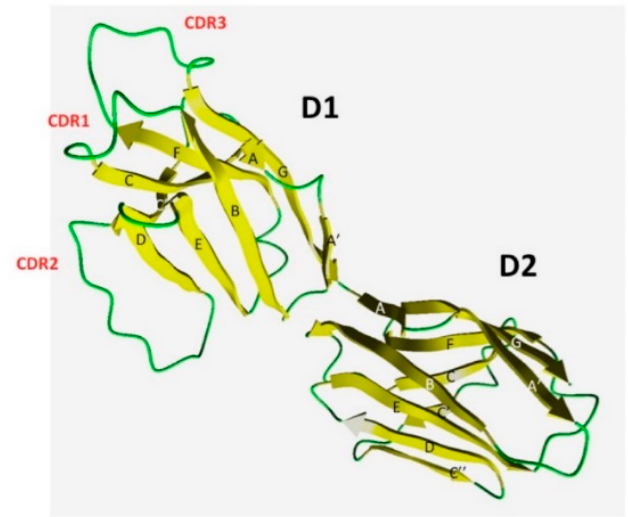
Figure 11. Ribbon representation of the molecular model of T. bernacchii pIgR extracellular region. The β -strands are labeled with uppercase letters (A–G). Loops that correspond to the three Complementary Determining Regions in the D1 domain are labeled (CDR) and colored (green).